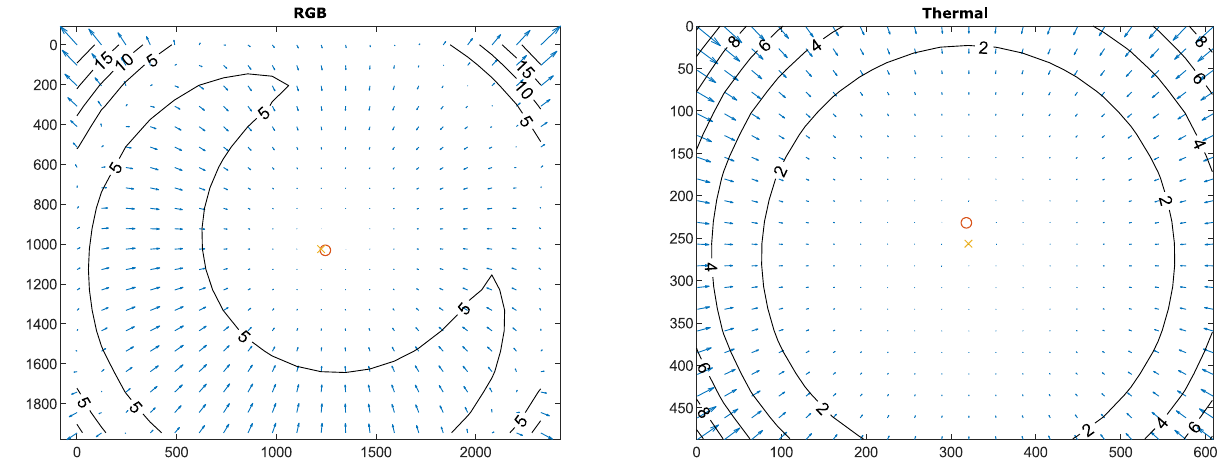
Figure 12. Geometric distortion of the RGB and thermal camera. The orange cross indicates the image center. The red circle indicates the principal point. Contour lines indicate distortion in pixels. Arrows indicate the magnitude and direction of the distortion.